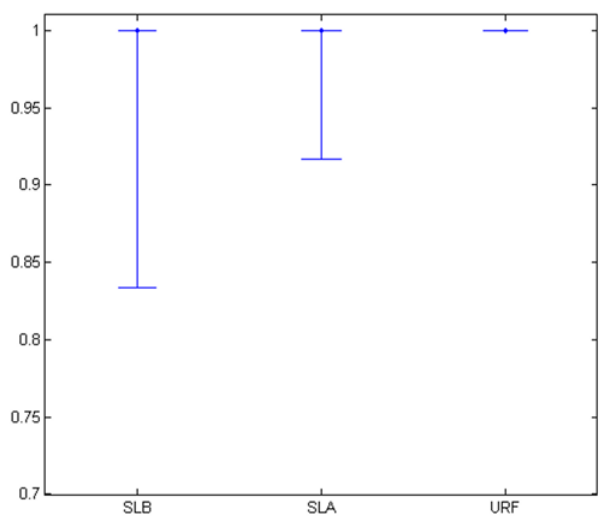
Figure 4. Percent correct classifications in esophageal data. Dots represent the median percent correct classifications and whiskers represent 5th and 95th percentiles.